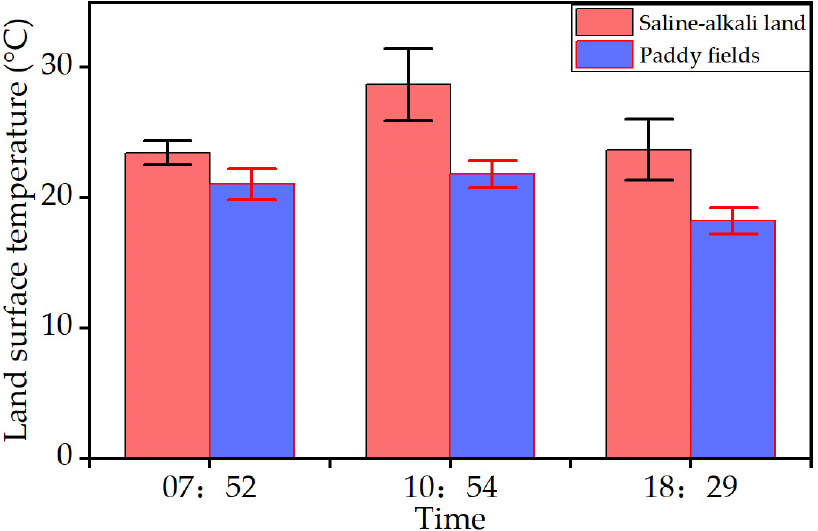
Figure 8. Statistical analysis of average surface temperature in saline–alkali land and paddy fields during the day. The error bars in the figure represent the standard deviation. Table 4. The daytime surface temperature difference(°C) between saline–alkali land and paddy fields.